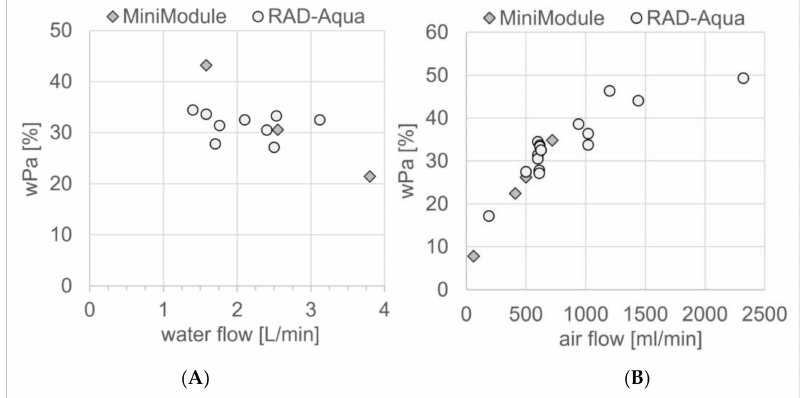
Figure 3. Dependence of the water / air proportion (wPa) of radon on water flow rate and air flow rate. For the experiments chosen for displaying the dependence on water flow rate ( A ) the air flow rate was kept constant at 0.61 ± 0.1 L / min. For experiments chosen for displaying the dependence on air flow rate ( B ), the MiniModule data points were limited to those using a water flow rate of 2.1 L / min while, for the RAD AQUA, all water flow rates are